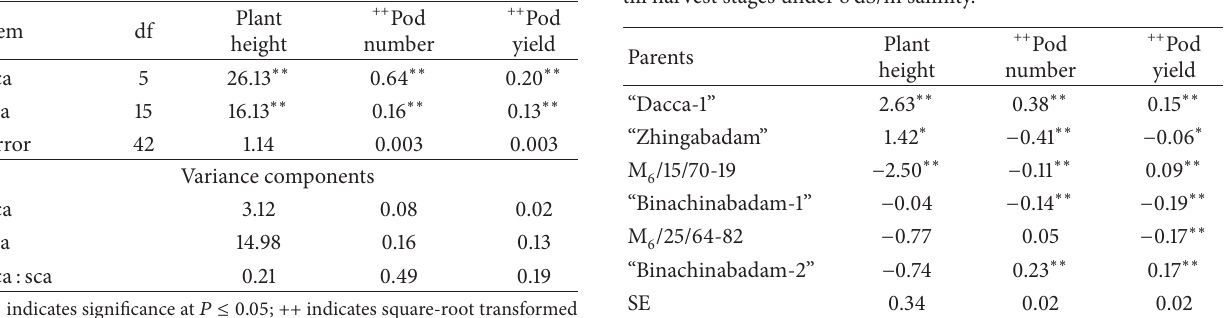
Table 6: Estimates of gca effects of parental lines in a 6 × 6 F 1 diallel population for pod yield and related traits during flowering till harvest stages under 8 dS/m